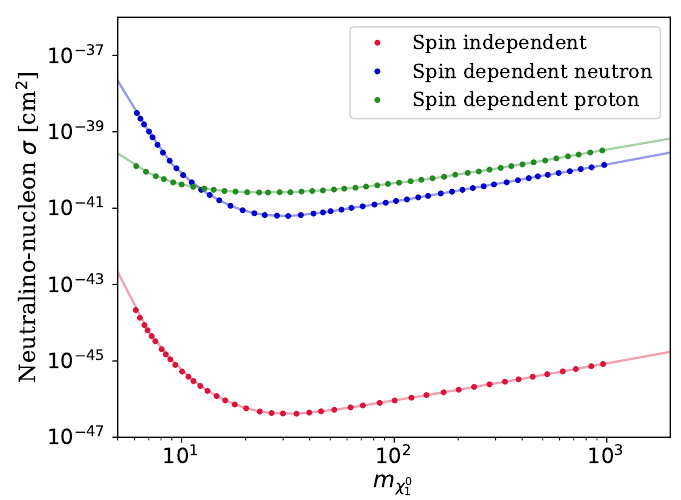
Figure 2 . Dark matter direct detection limits in plane of dark matter mass and spin-(in)dependent nucleon scattering cross section. The dots correspond to data extracted from refs. [73, 74], while the solid line is the extrapolation we